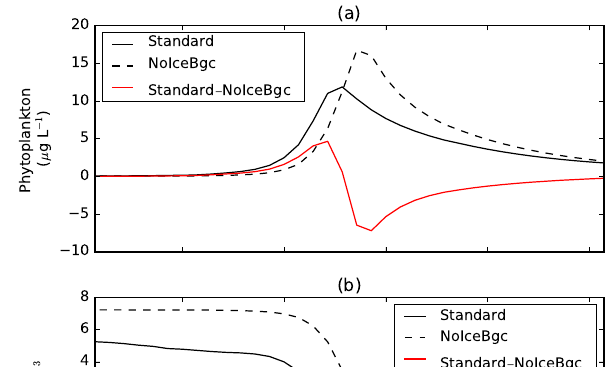
Table 2. Sensitivity of simulated under-ice DMS to the incorporation of the sea-ice sulfur cycle and ecosystem. Overall changes were calculated by taking the difference in the time-integrated under-ice DMS concentrations between the two runs of interest and dividing it by the time-integrated under-ice DMS concentration in the run being subtracted. Runs to be compared Maximum concentration Overall change (implications of the comparison) difference (nmolL − 1 ) (%) Standard – NoIceSul (impact of sea-ice sulfur cycle) 2.4 18 NoIceSul – NoIceBgc (impact of sea-ice ecosystem) 4.1 − 16 Standard – NoIceBgc (impact of sea-ice biogeochemistry) 5.6 − 1